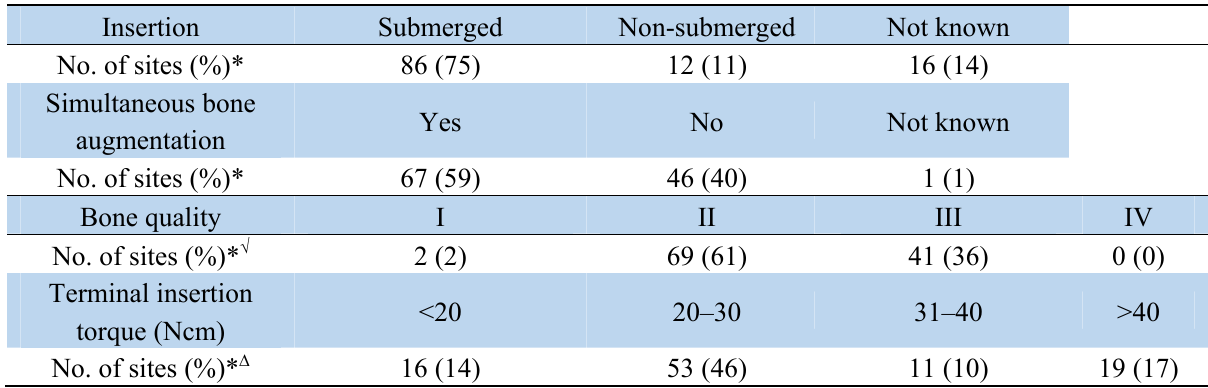
Table 2. Surgical characteristics.